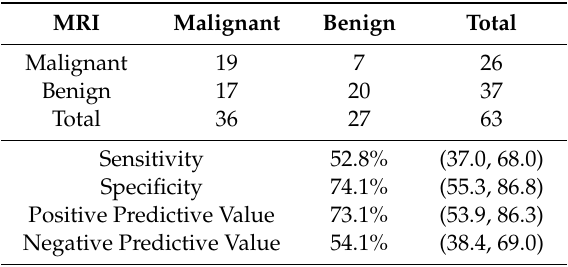
Table 4. Accuracy of MRI in comparison to histology, taken as gold standard (CI 95%).